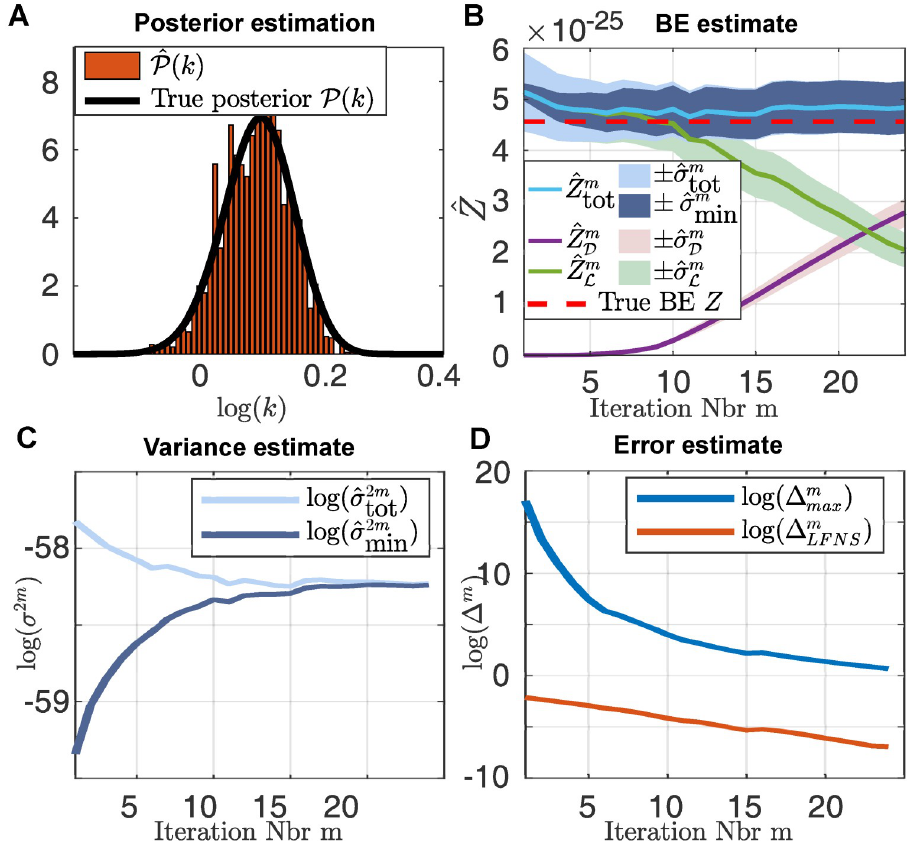
Fig 3. Inference on the birth-death model. A : Histogram of the posterior P ð k Þ estimate obtained with LF-NS using N = 100 and H = 100. The true posterior is indicated in black. B : Development of the estimation of the Bayesian evidence using the estimation based solely on the dead points ^ Z , the estimate approximation from the live points ^ Z D L and the estimation based on both ^ Z . The corresponding standard errors are indicated as the shaded areas. The true tot and the lower Bayesian evidence is indicated with the dashed red line. C : Estimate of the current variance estimate ^ s 2 m tot bounds for the lowest achievable variance ^ s 2 . D : Developments of the different error estimations for each min